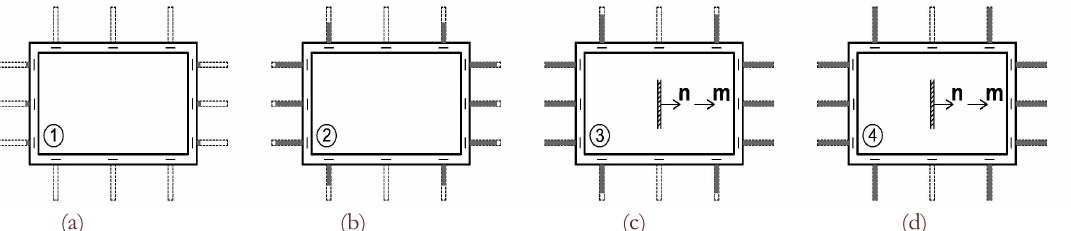
Figure 8: Example 1: